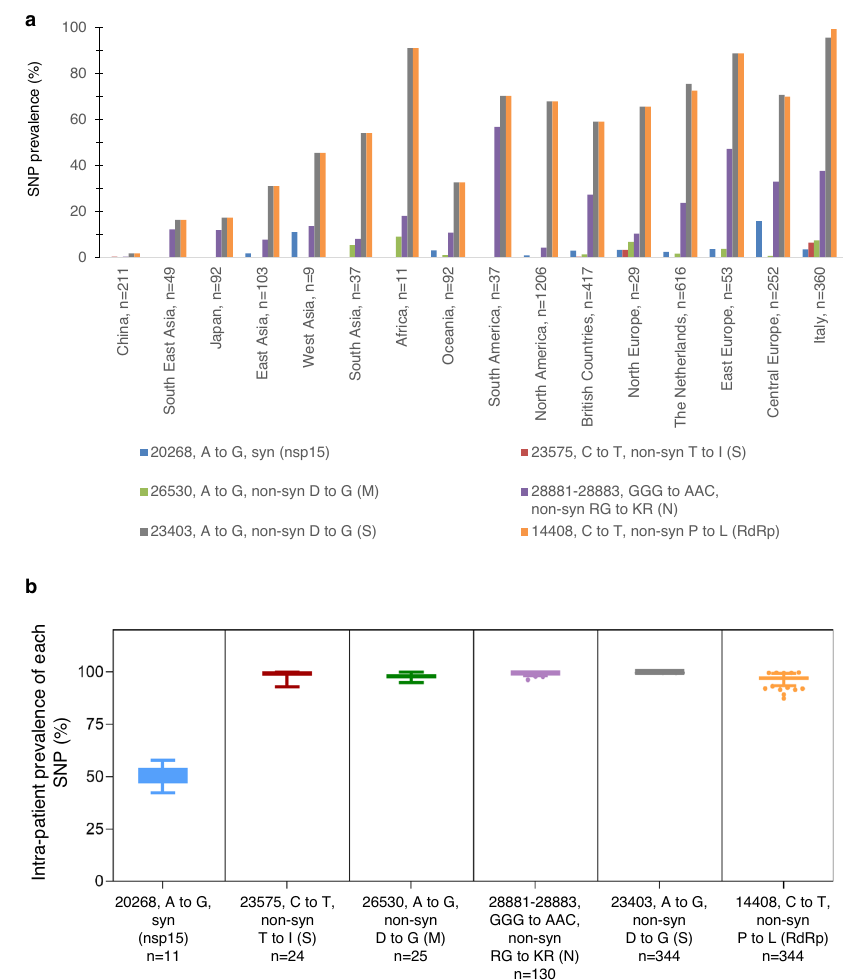
Fig. 4 Prevalence of most representative single nucleotide polymorphisms (SNPs) in SARS-CoV-2 genomes isolated in Lombardy according to geographical locations and their intra-patient prevalence. a Frequency of single nucleotide polymorphisms (with respect to the Wuhan reference genome NC_045512.2) among SARS-CoV-2 sequences according to different geographical location. Italian sequences include the 6 and 8 sequences from North and Central Italy present in Gisaid at April 10. b Intra-patient prevalence of most representative SNPs in North Italian SARS-CoV-2 sequences according to sample date. Box and whiskers plots indicate the median and interquartile range of intrapatient prevalence. SNP: single nucleotide polymorphism; syn: synonymous; non-syn: non-synonymous; nsp15: non-structural protein 15; S: spike; M: matrix; N: nucleocapsid; RdRp: RNA-dependent RNA